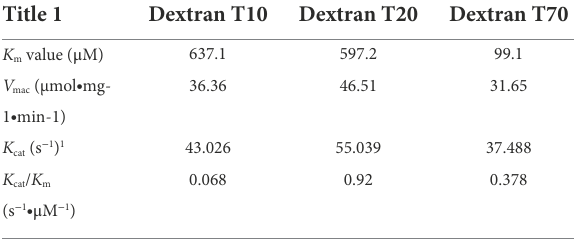
TABLE 3 Enzyme kinetics of CeDex against different